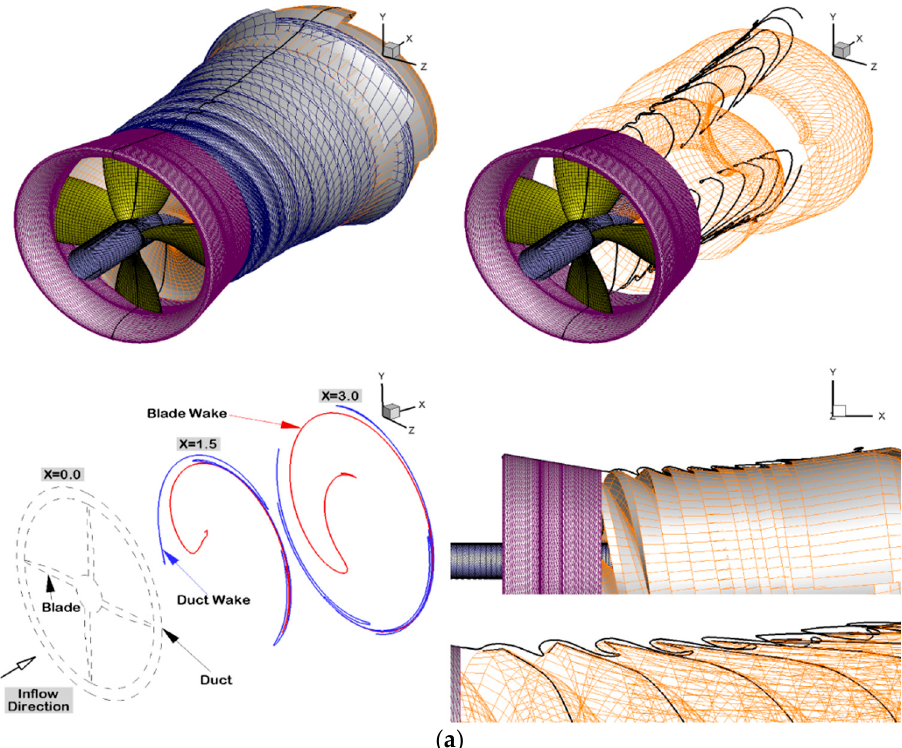
Figure 8. Convergence history of the predicted blade thrust and torque coefficients with number of panels on the blade and the duct. B(c60s20) and D(c160c’20), for example, represent 60 × 20 (chordwise × spanwise) panels on the blade and 160 × 20 (chordwise × circumferentially) panels on the duct. Full wake alignment is applied to both blade and duct wakes. 2 The simulation is performed at the Texas Advance Computing Center (TACC) at The University of Texas at Austin (Austin, TX 78703, USA). URL: http://www.tacc.utexas.edu.